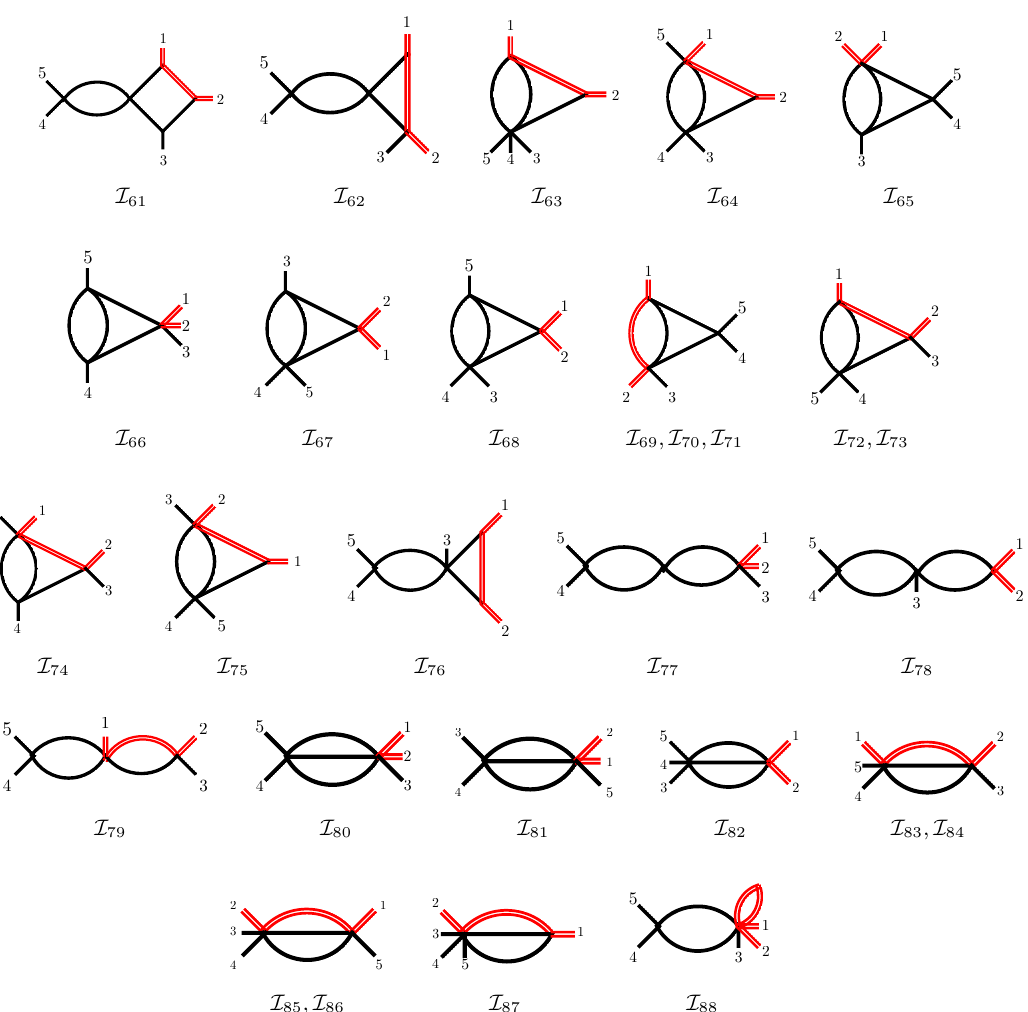
Figure 3 . The remaining 23 diagram topologies describing 28 out of 88 master integrals. The label of the individual sub-figures lists the master integrals belonging to the corresponding topology. Massive propagators and massive external momenta are indicated by red